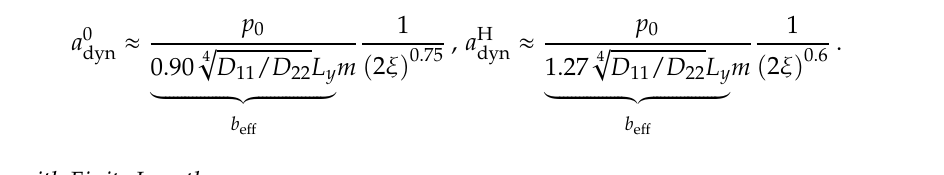
π 4 D 3 = p 0 L 22 ). y / stat